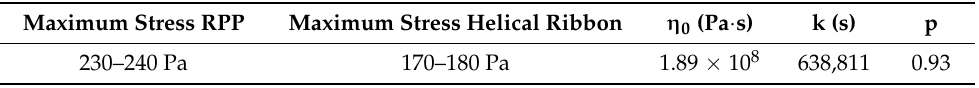
Table 5. Maximum applicable stresses before sample rupture regarding both geometries used for M200 sample and fitting parameter values for the Cross model applied to the complete viscous flow